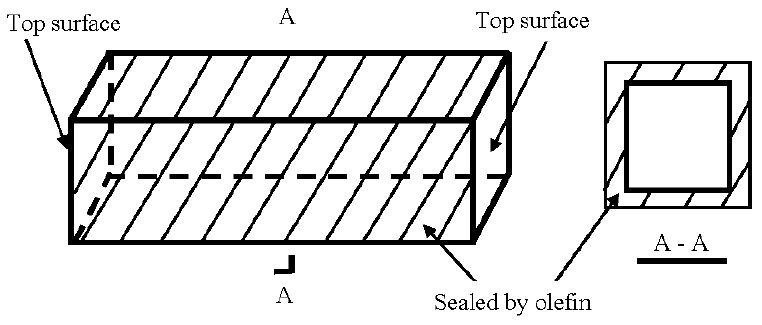
Figure 3. Sealed mortar specimen to be soaked in sodium chloride